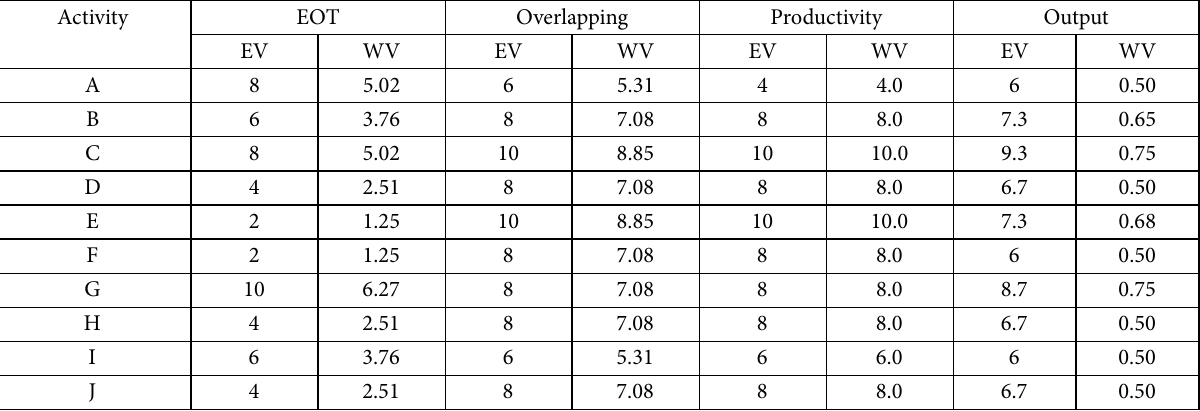
Table 10. The importance of each activity by fuzzy inference